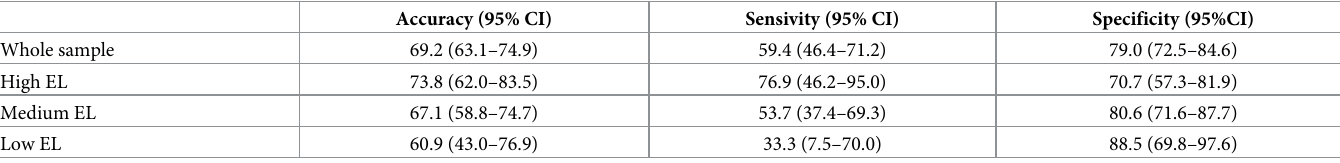
Table 3. Analysis of accuracy, sensitivity and specificity of the Baecke questionnaire to assess physical activity against the accelerometry